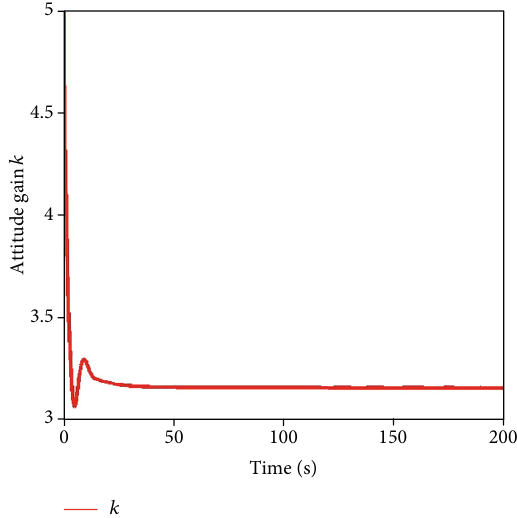
22: Time histories of attitude gain k in Case 3 when k ð 0 Þ = 5 .